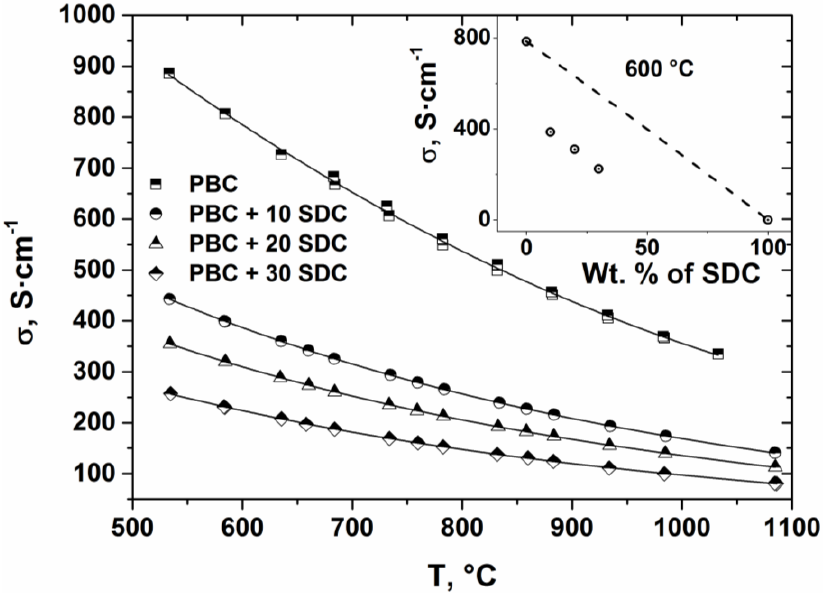
Figure 7. Temperature dependences of total conductivity of (100 − y ) PBC- y SDC ( y = 0–30 wt.%) in air. The inset shows variation of the total conductivity of the composite with SDC content at 600 °C in air. Dashed line represents the weighted sum of PBC and SDC conductivity.